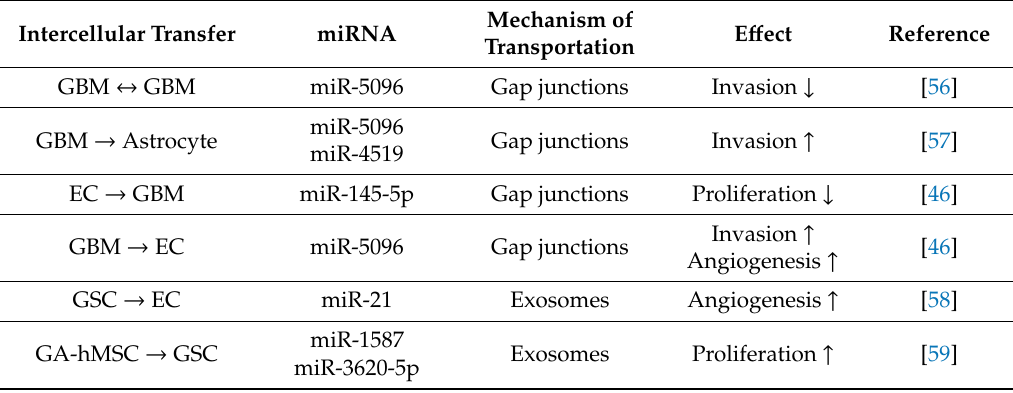
Table 1. Principal interactions between glioblastoma (GBM) cells and normal cell populations in the tumor microenvironment. EV: extracellular vesicle, EC: endothelial cell, GSC: glioma stem cell, and GA-hMSC: glioma-associated mesenchymal stem cell; ( ↑ increased; ↓